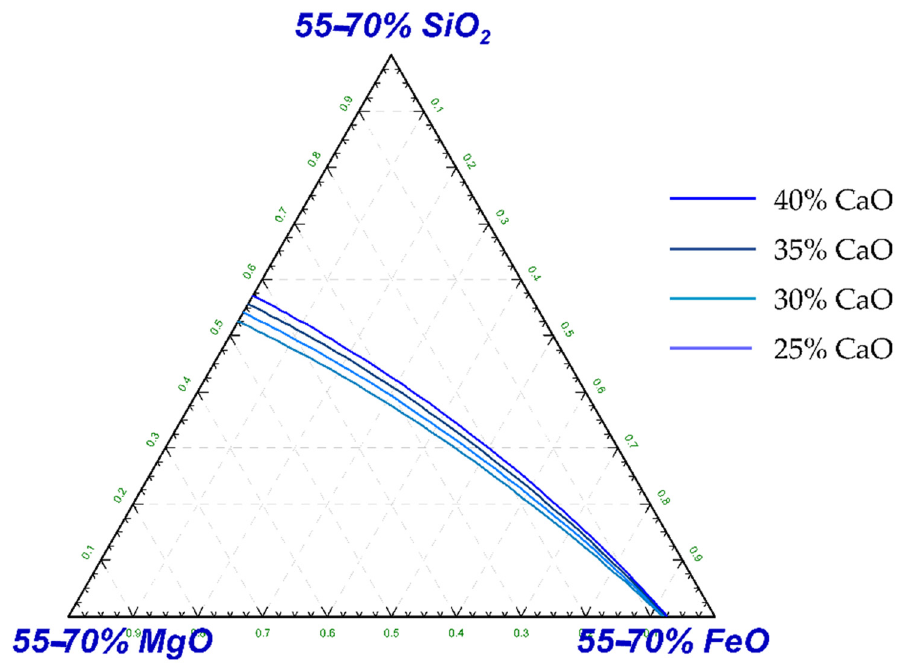
Figure 3. Projected MgO saturation lines in the pseudo-ternary sections at 25%, 30%, 35%, and 40% CaO at 1600 °C in the system CaO–SiO 2 –FeO–MgO–5%Al 2 O 3 ; all calculations from Factsage™.